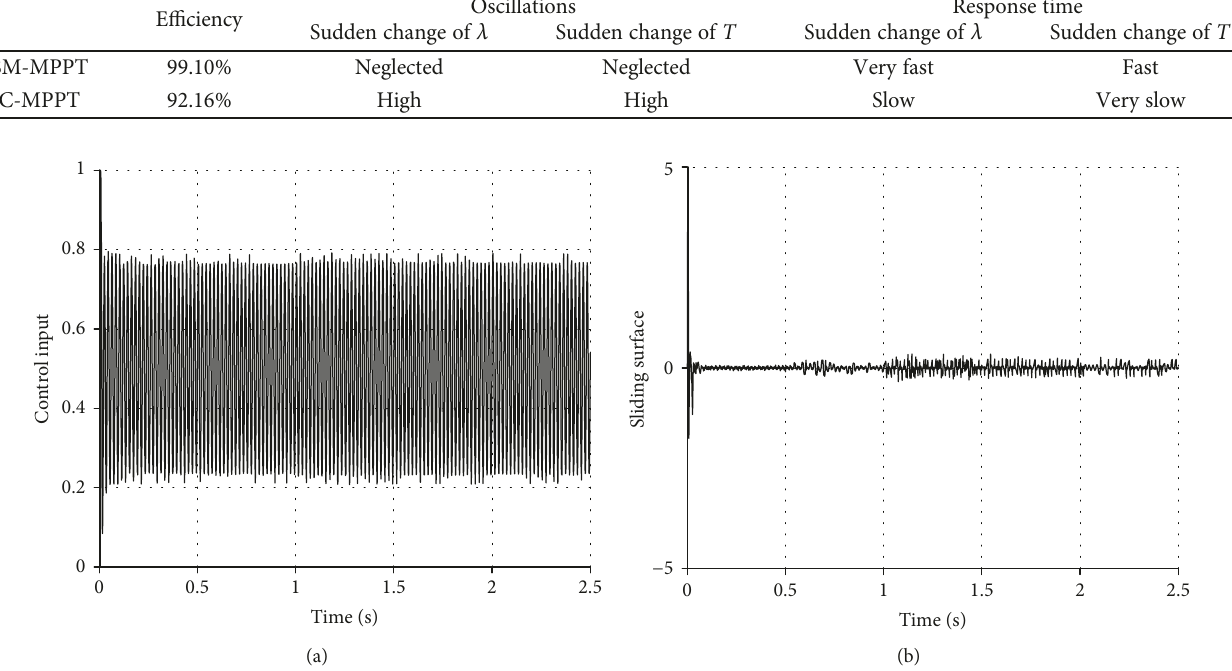
Figure 11: Control input and the sliding surface used to design the control law of the inverter.